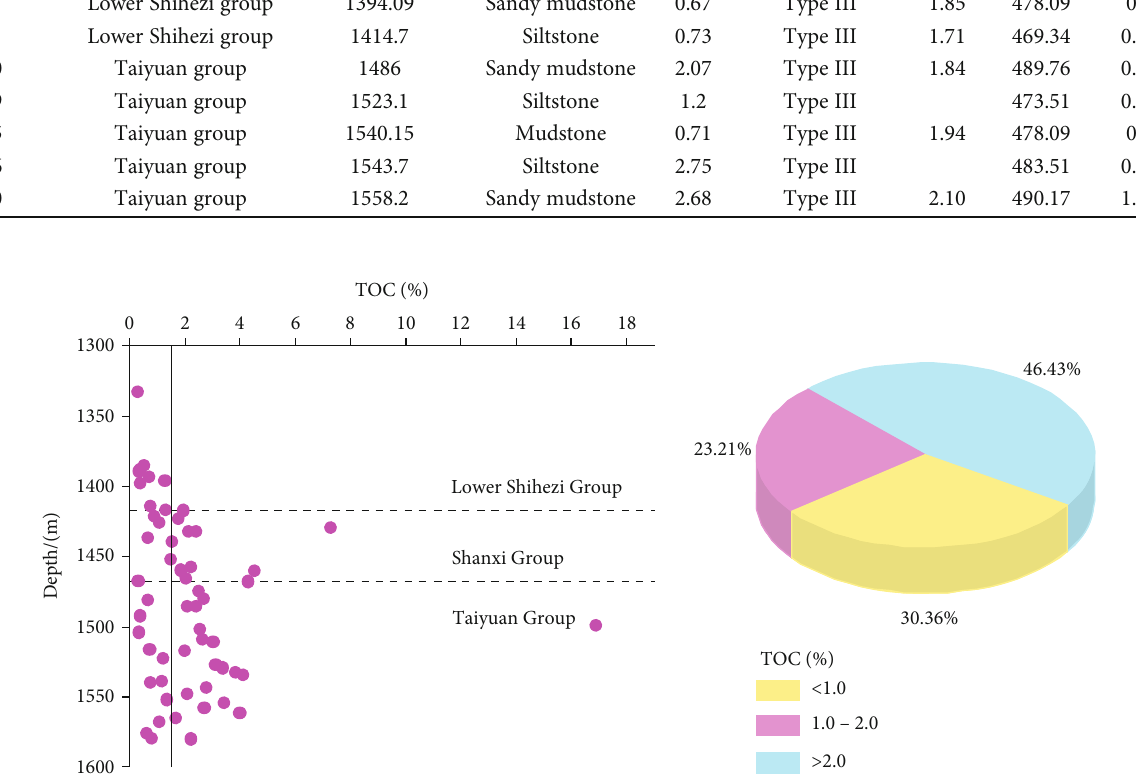
Table 1: Geochemical parameters of shale gas reservoir samples from Lower Shihezi group to Taiyuan group in Y1 well. Sample No.